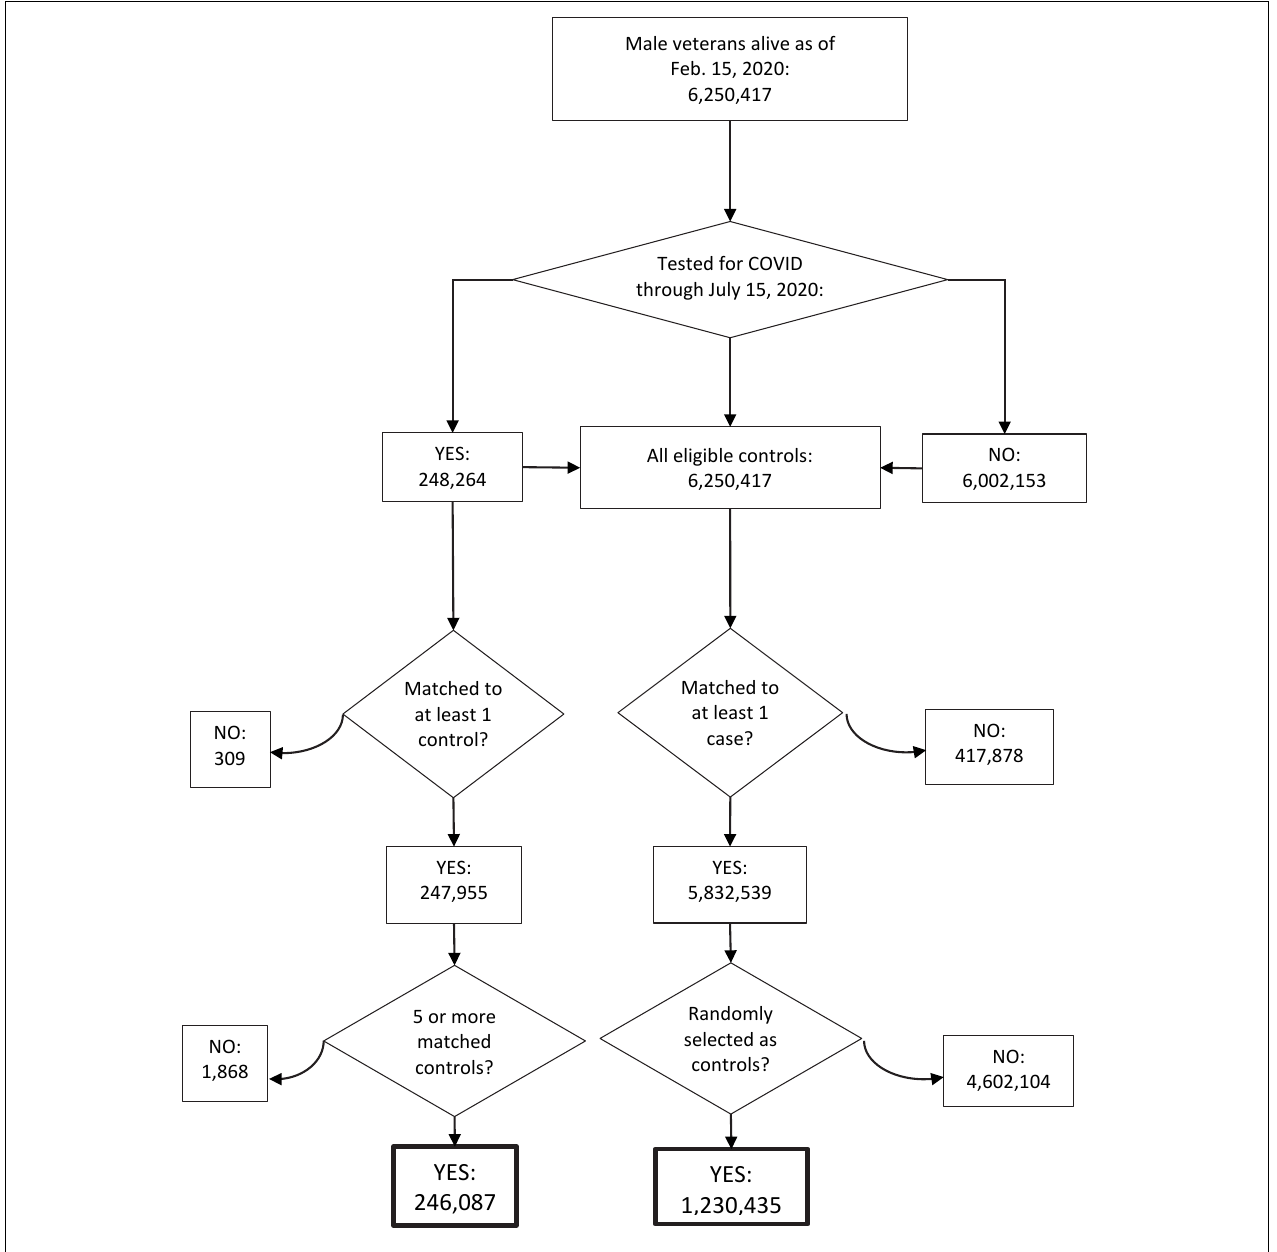
FIGURE 1 | Consort diagram for the selection of patients for the model for the propensity to be tested for SARS-CoV-2. Curved arrows indicate excluded patients.